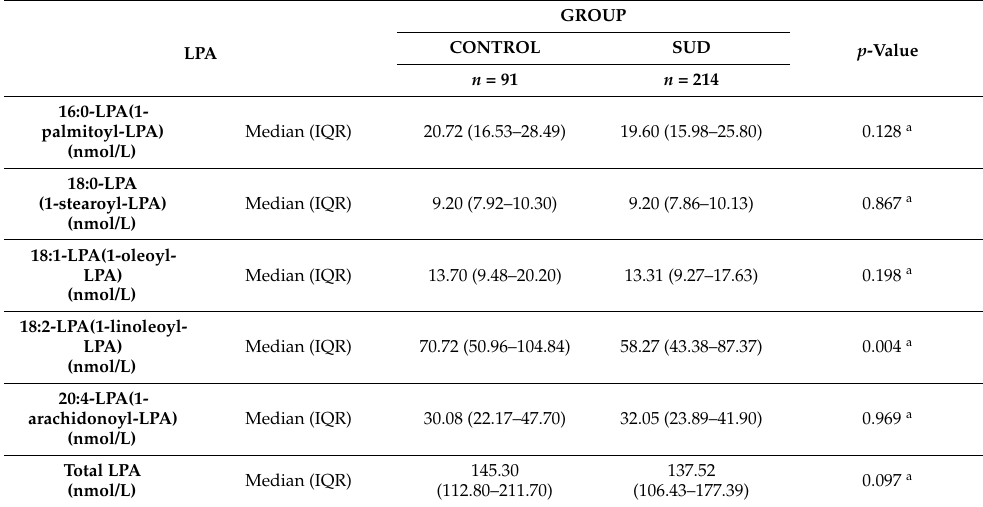
Table 2. Plasma concentrations of LPA species and total